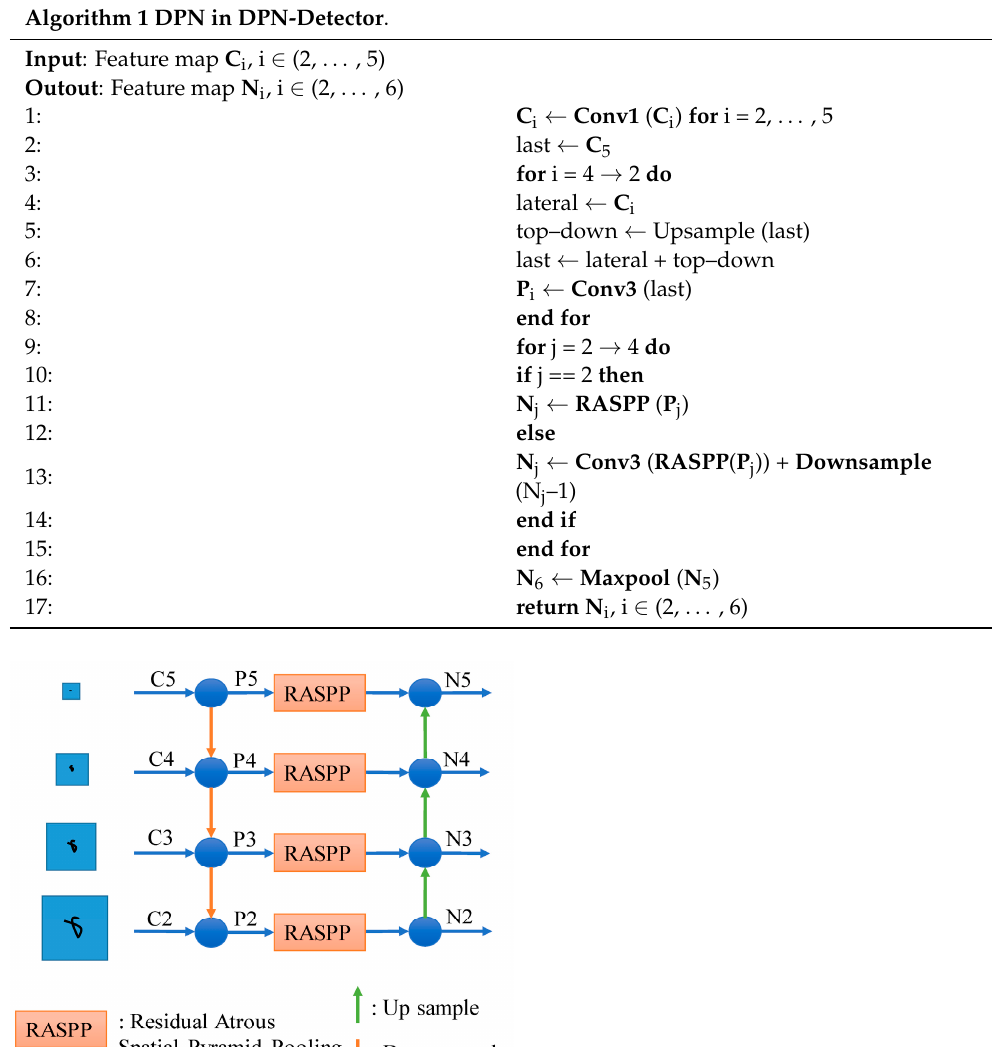
Algorithm 1 DPN in DPN-Detector .